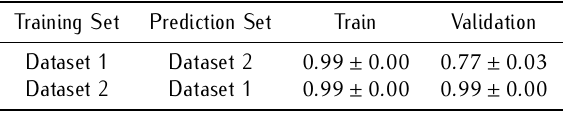
Table 4. F1-scores on training and validation datasets for both training orders